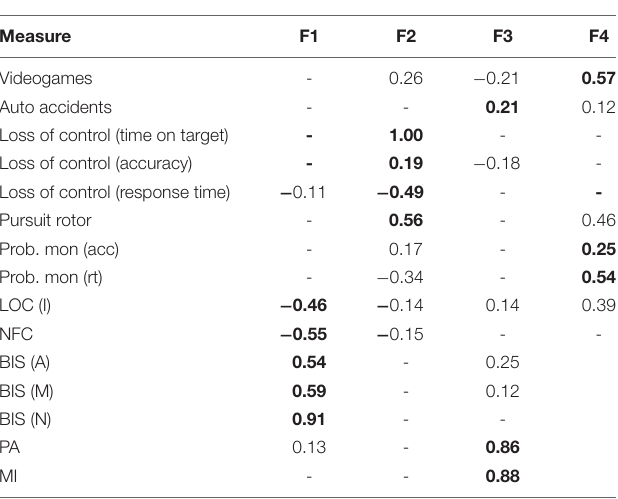
TABLE 4 | Factor scores for the exploratory factor